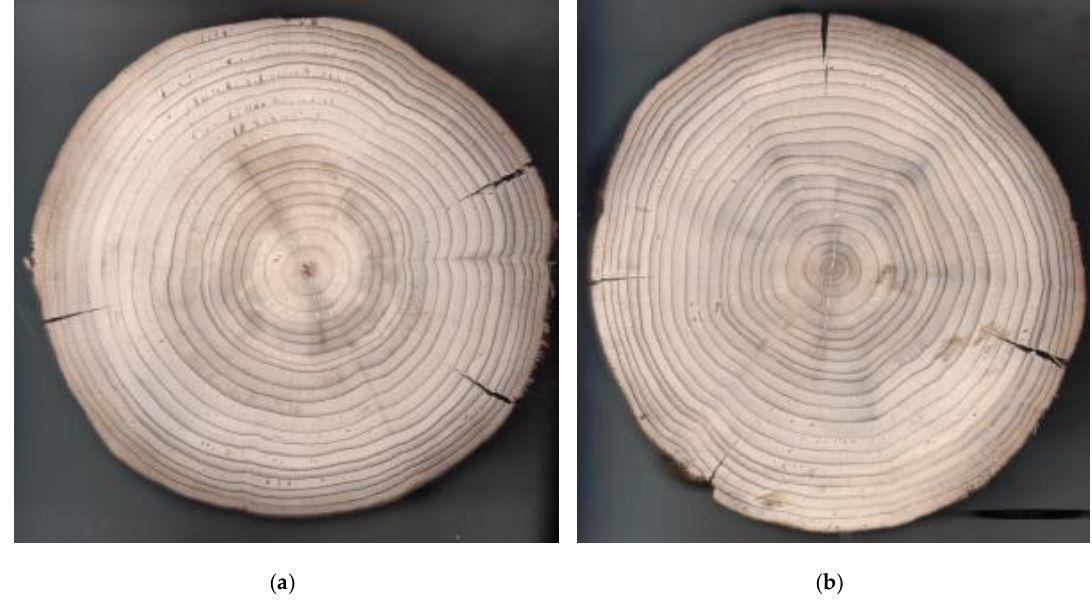
Figure 4. Cross-sections of spruce wood samples taken from the forest road in section OGW of Graszk